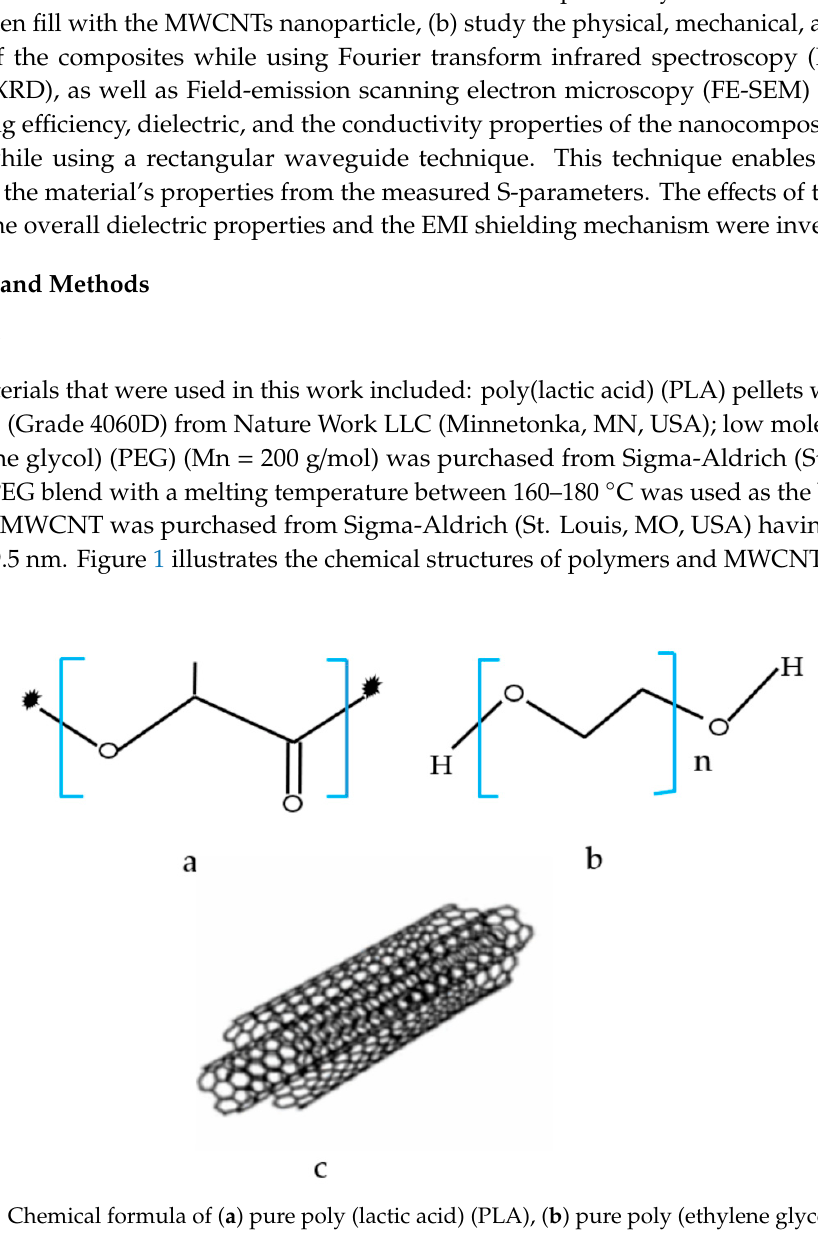
Figure 1. Chemical formula of ( a ) pure poly (lactic acid) (PLA), ( b ) pure poly (ethylene glycol) (PEG), and ( c ) multi-walled carbon nanotubes (MWCNTs) structure.